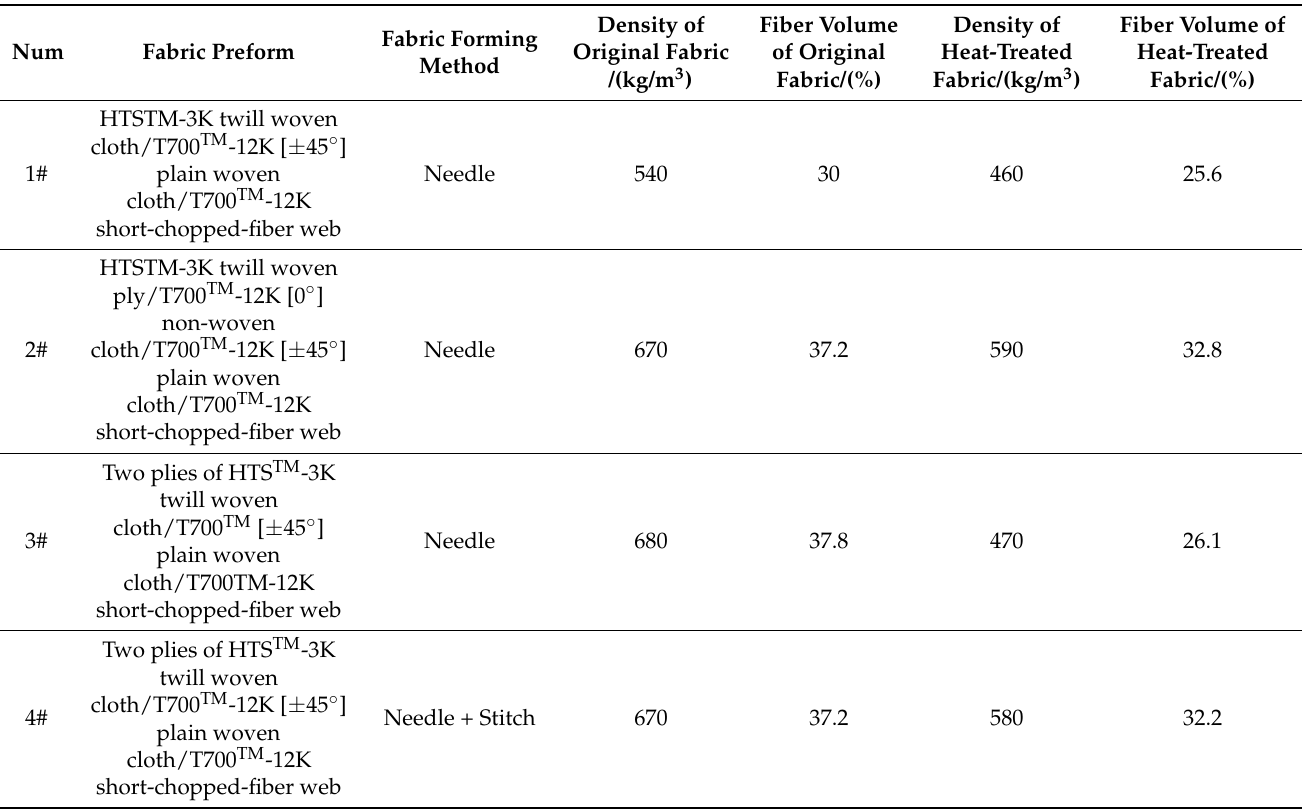
Table 1. Composite fabric raw materials and woven structural